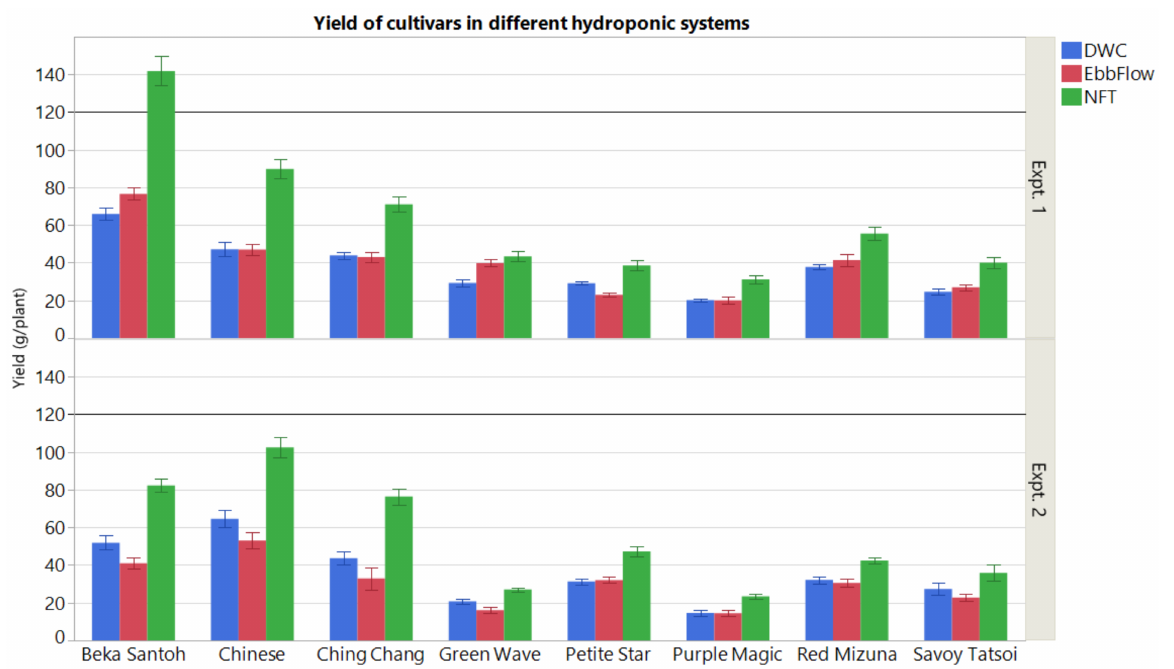
Figure 2. Yield of eight leafy vegetables grown in three hydroponic systems: DWC, deep water culture; EbbFlow, Ebb and Flow; NFT, nutrient film technique. Top, Expt. 1 (from 22 April to 23 May 2019); bottom, Expt. 2 (12 June to 3 July